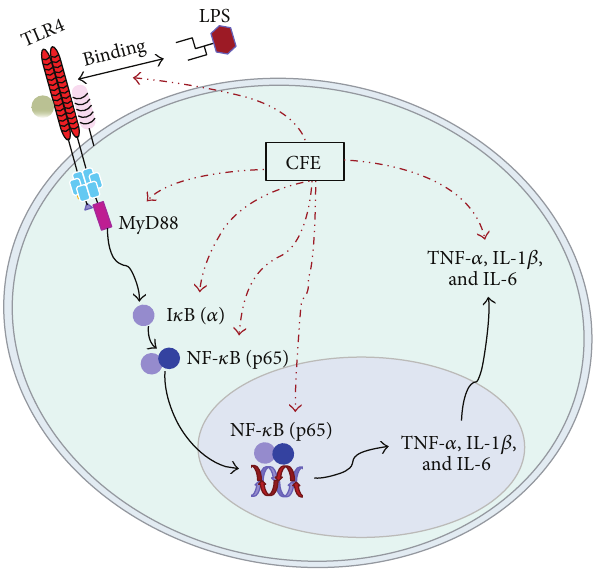
Figure 7: The underlying mechanism of CFE on the TLR4 signaling pathway. The red dotted arrows indicate the inhibitory sites and effects of